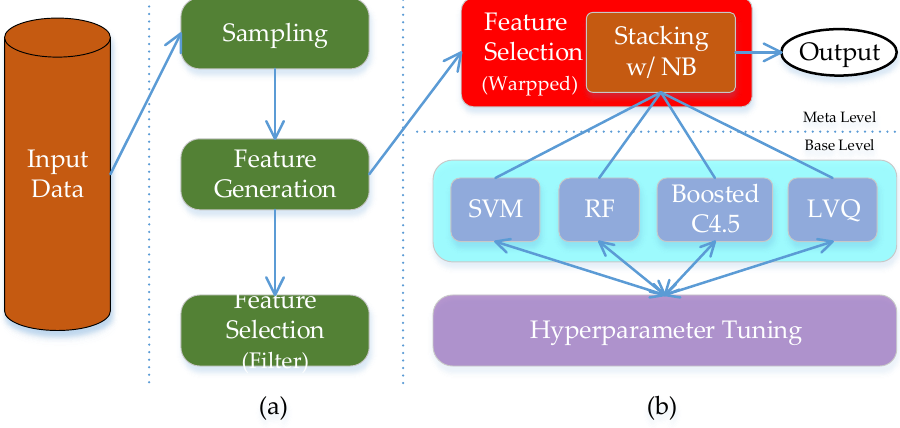
Figure 12. The hybrid model adopted from; ( a ) Preprocessing ( b ) Model introduction [98].